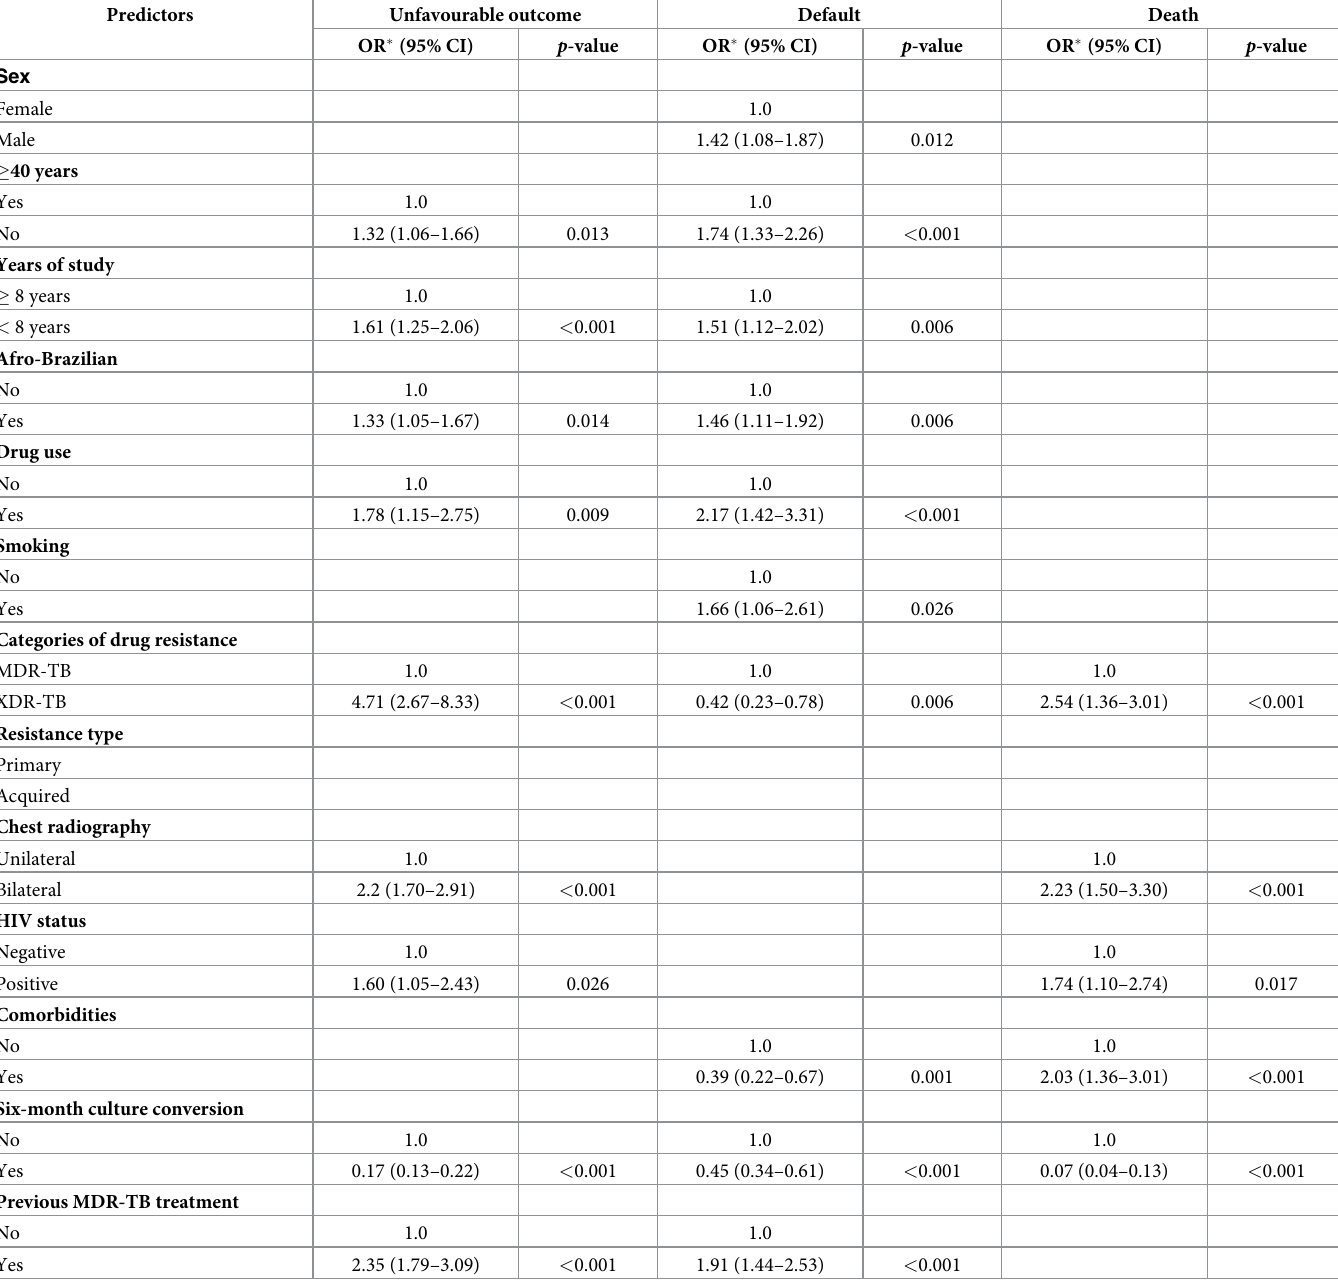
Table 5. Multivariate analysis: Predictors of unfavourable outcome, default and death among 2269 patients with MDR-TB and XDR-TB.